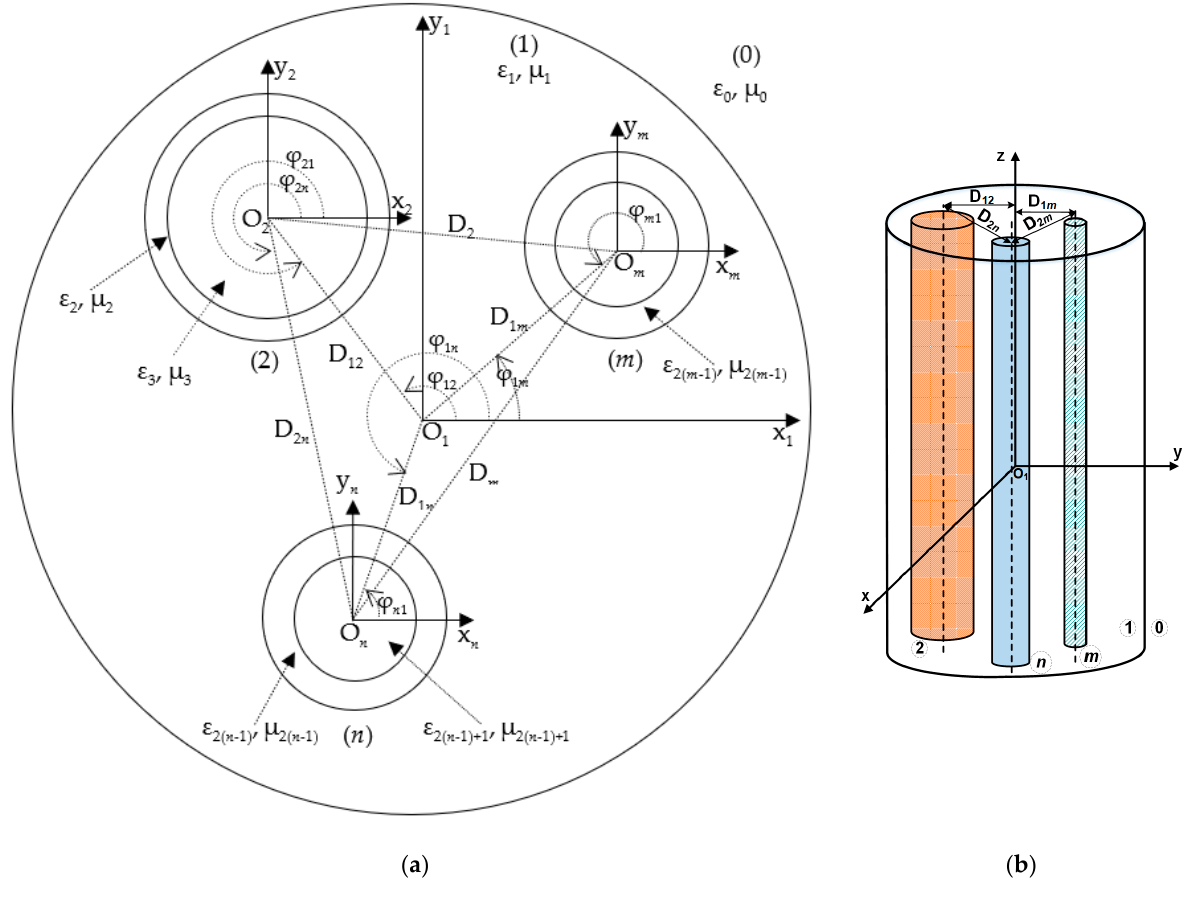
Figure 1. ( a ) Cross-section (normal to the complex cylindrical structure’s axes) of the general configuration under consideration, consisting of L − 1 parallel stratified circular dielectric cylinders (2, 3, …, L ), embedded in a dielectric circular cylindrical housing (1) surrounded by unbounded empty space (0). ( b ) A specific example of the configuration, consisting of a host cylinder with three cylindrical inclusions (3D view).